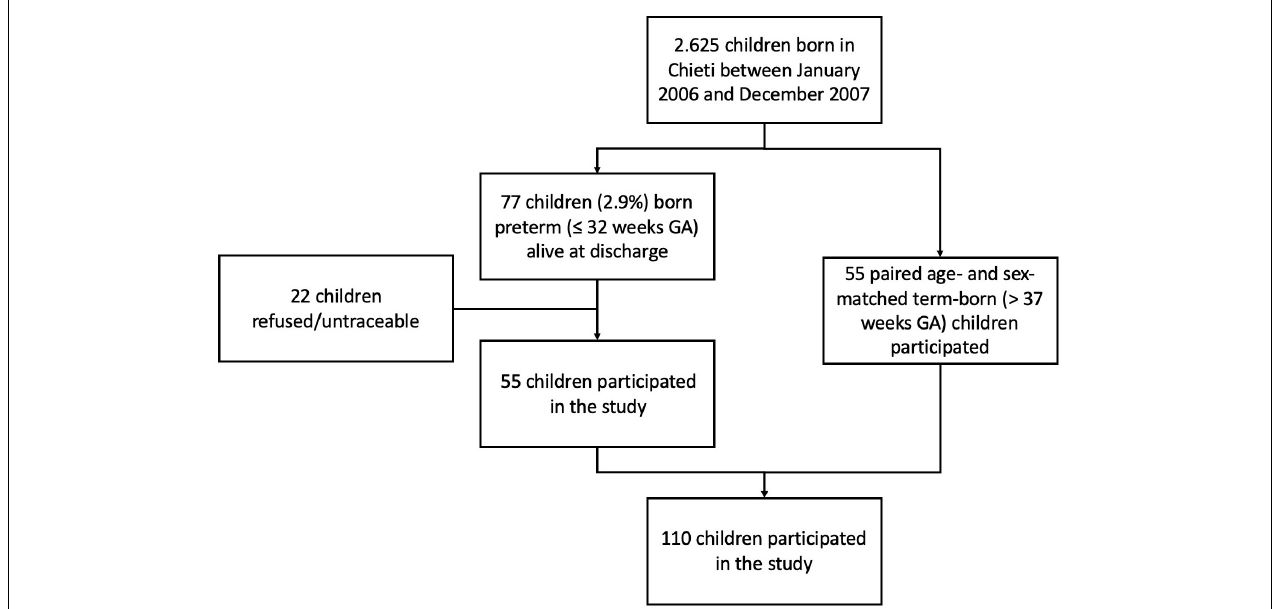
FIGURE 1 | Flow chart of the study. GA, gestational